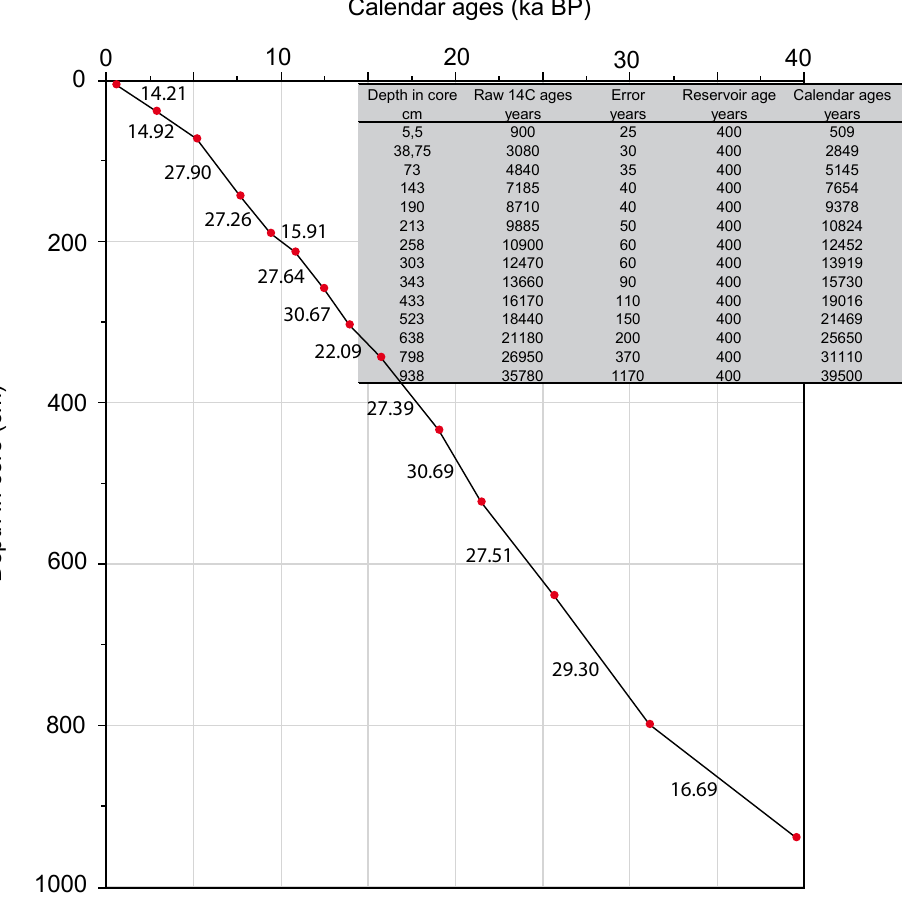
Fig. 2. Age model of core GeoB4905-4. The table details the different steps taken to develop an age-model from raw 14C dates to calibrated ages. The graph depicts calibrated ages versus depth. The line depicts the linear interpolation between two consecutive ages. Age model of core GeoB4905-4 was previously published in Adegbie et al. (2003) and Weldeab et al. (2005). More details can be found therein. Numbers associated with the curve represent sedimentation rates in